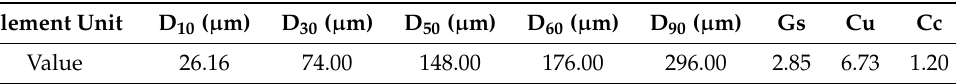
Table 3. Physical parameters of the utilized silica tailings (ST).